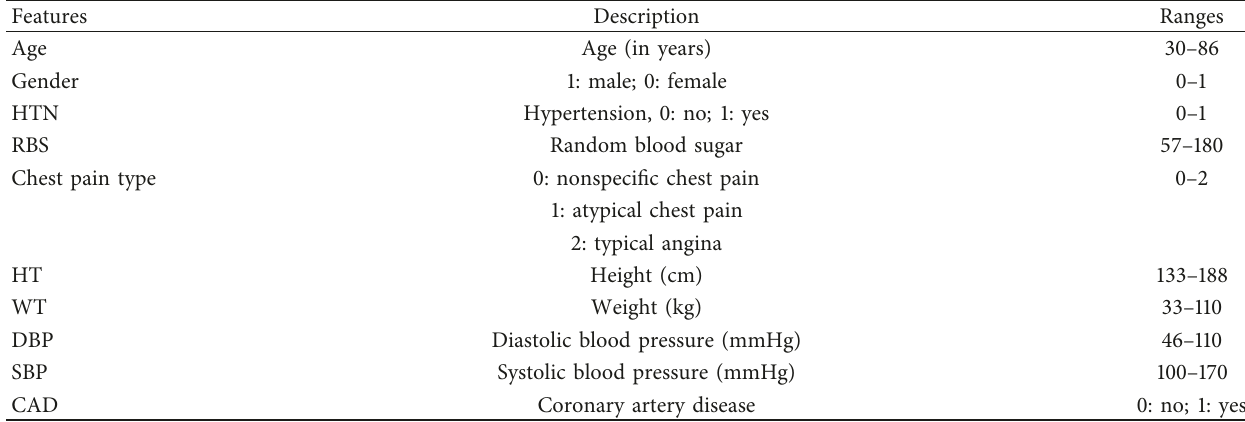
Table 2: Patient clinical data